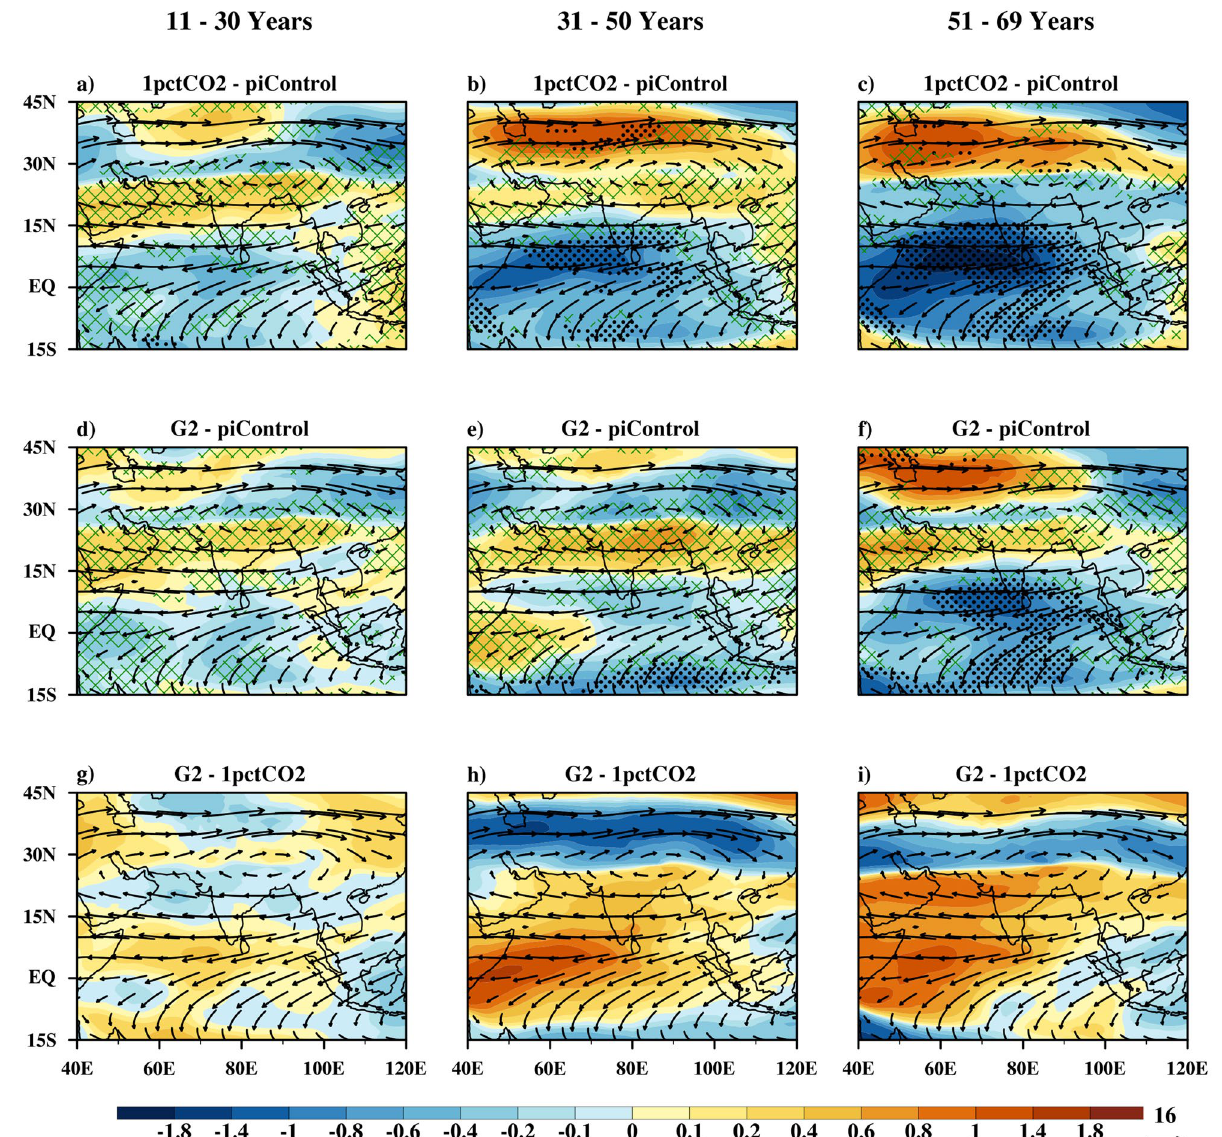
Figure 4. As in Fig. 2 but for wind speed (m/s) at 200 hPa. Vectors show piControl winds at same